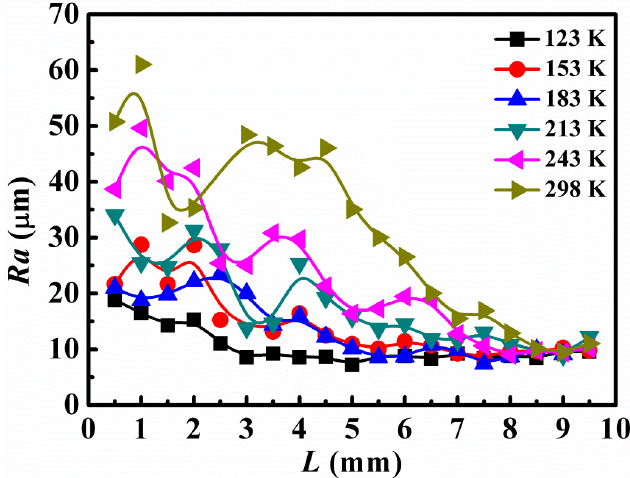
Figure 5. Fracture surface roughness, R a, as a function of crack propagation distance, L , at different temperatures.